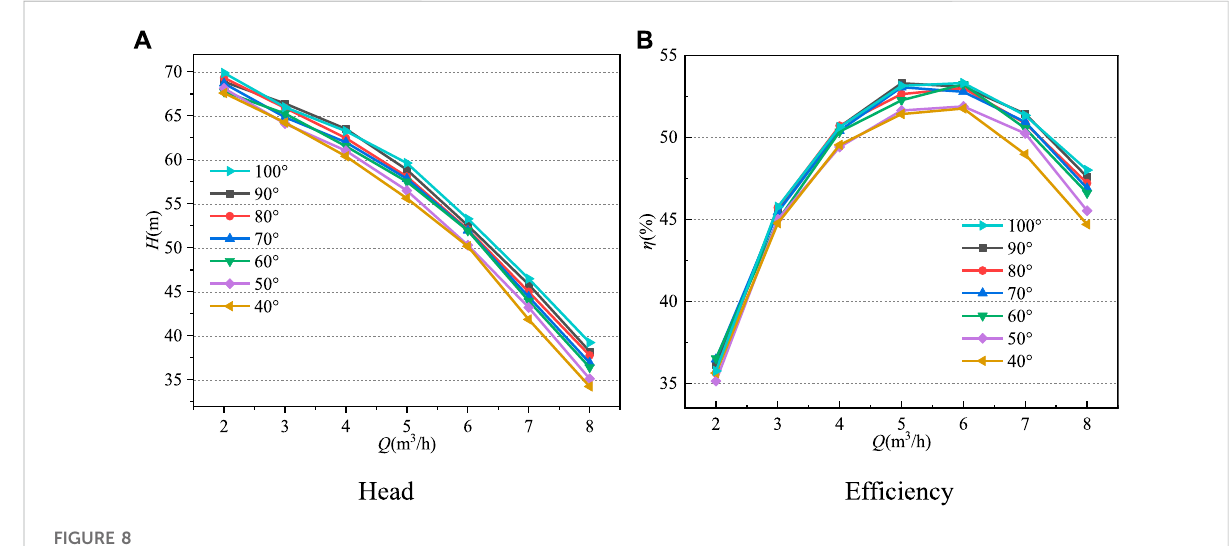
FIGURE 8 Comparison of external characteristics at different outlet setting angles of space